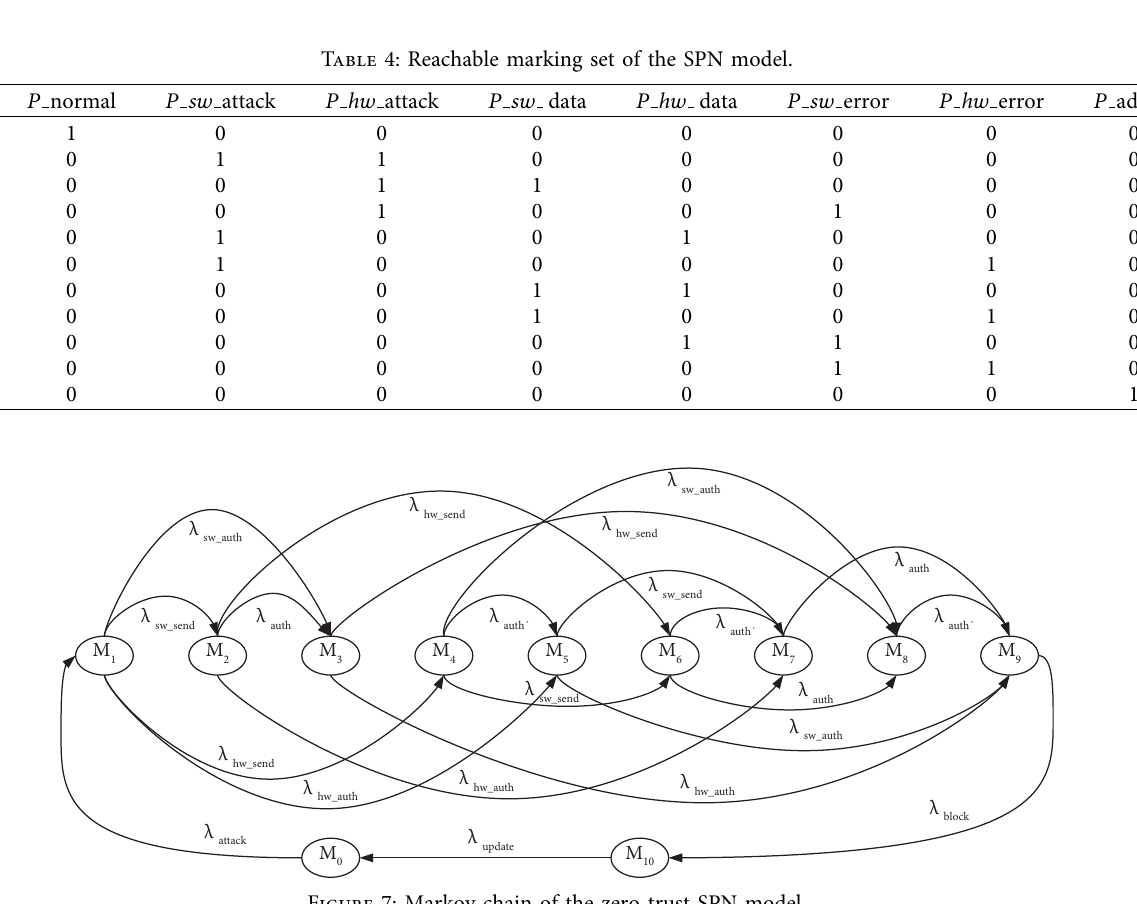
Figure 7: Markov chain of the zero-trust SPN